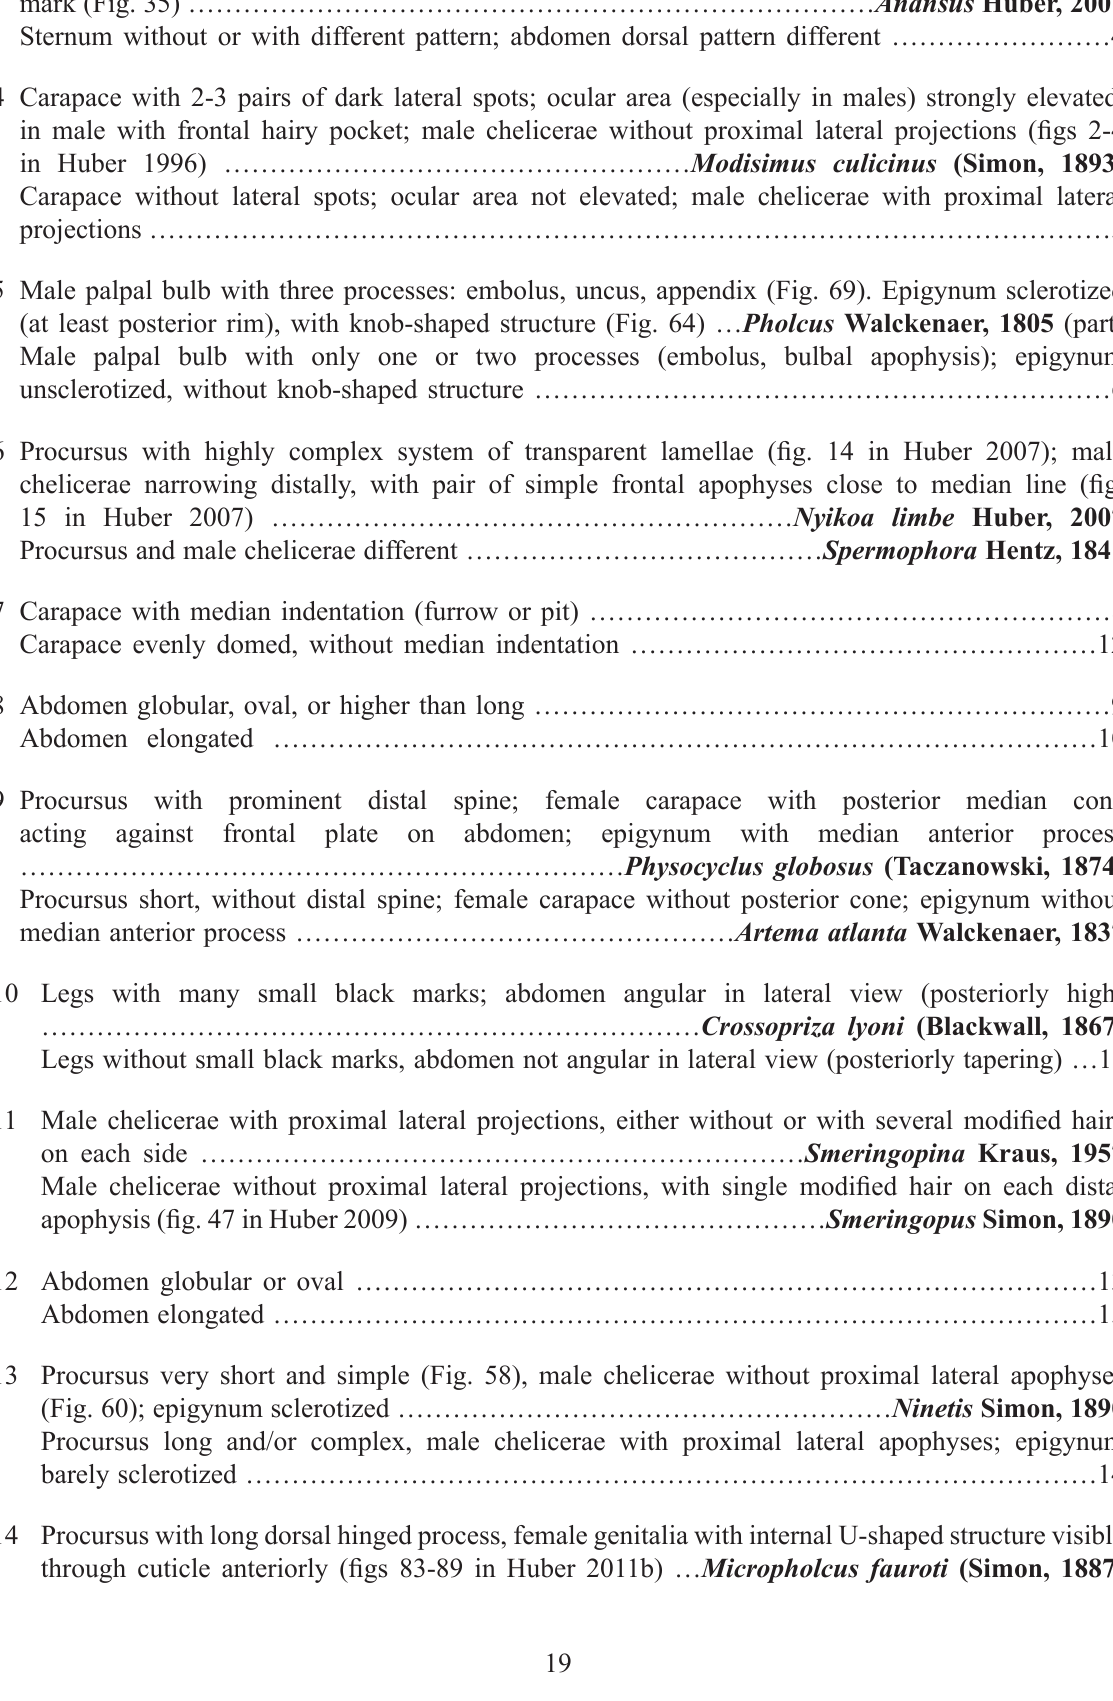
- 13 Procursus very short and simple (Fig. 58), male chelicerae without proximal lateral apophyses (Fig. 60); epigynum sclerotized ……………………………………………… Ninetis Simon, 1890 - Procursus long and/or complex, male chelicerae with proximal lateral apophyses; epigynum 14 Procursus with long dorsal hinged process, female genitalia with internal u-shaped structure visible through cuticle anteriorly (figs 83-89 in Huber 2011b) … Micropholcus fauroti (Simon, 1887)